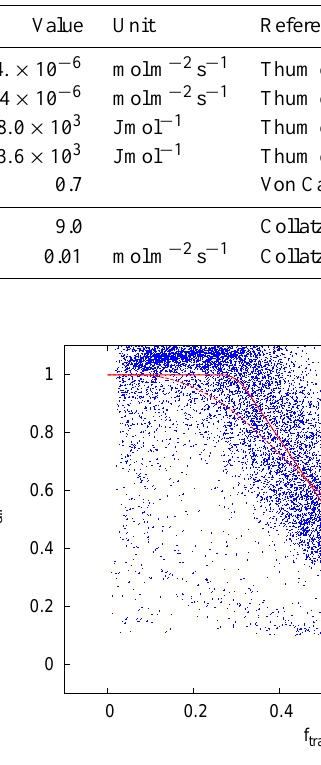
Figure 1. Relationship between the relative amount of incoming ra- diation at the surface (as a fraction of top-of-atmosphere radiation) f trans and diffuse fraction f dif . Shown are data between June 2004 and December 2010. Data points with surface fractions ≤ 0 or > 1, as well as data points with diffuse fractions < 0 . 1 or > 1 . 25, were omitted. The original relationship by Spitters et al. (1986) (dashed, R 2 = 0 . 61) as well as the reparameterised relationship (full line, R 2 = 0 . 66) are